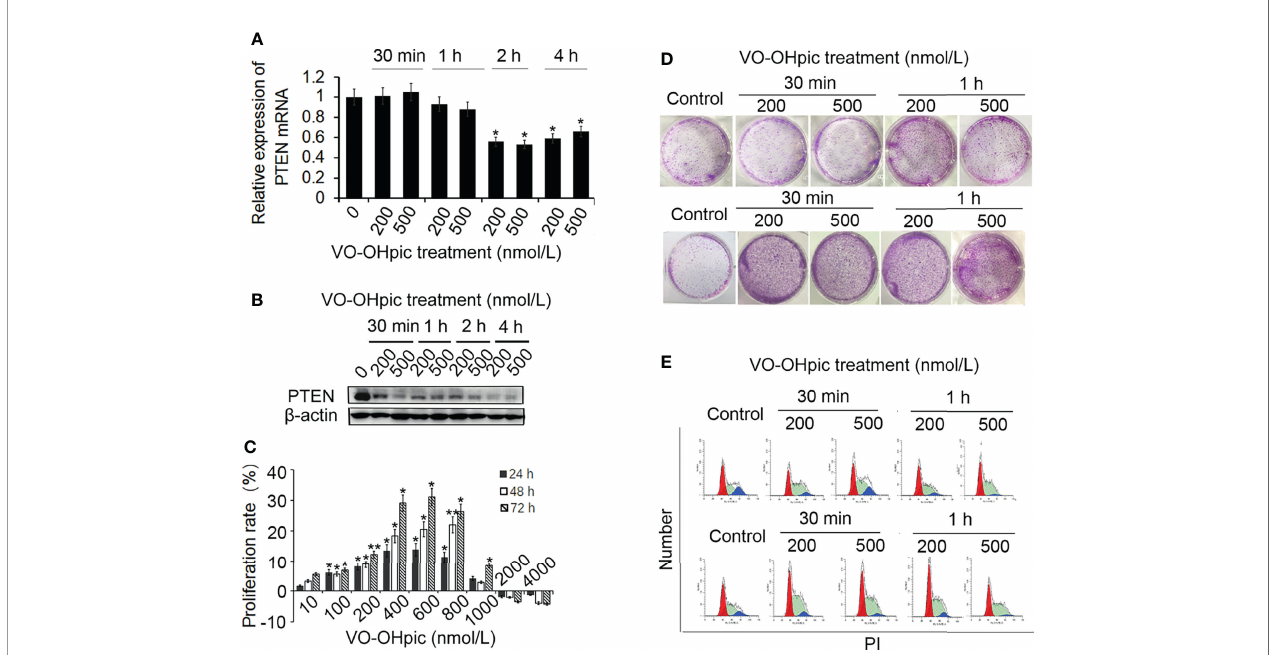
FIGURE 1 | Effects of VO-OHpic on proliferation of 4T1 cells by inhibiting PTEN gene expression. 4T1 cells were treated with 200 or 500 nmol/L VO-OHpic for 0.5 – 4 h and PTEN mRNA expression was detected by real-time quantitative RT-PCR (A) , and PTEN protein expression was detected by western blotting (B) . (C) Effects of different concentrations of VO-OHpic for 4 h on proliferation activity of 4T1 cells. (D) Effects of VO-OHpic on cell colony formation and cell cycle phase distribution in 4T1 cells (E) after 0.5 – 4 h treatment. * P <0.05, ** P <0.01 compared with the control